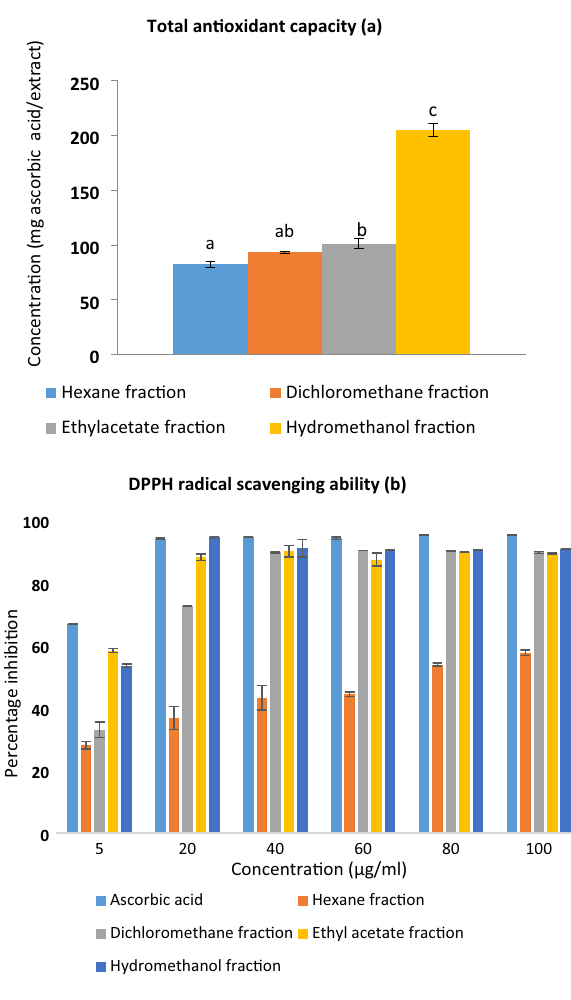
Fig. 2 Antioxidants capacity and free radical inhibiting activity of A. floribunda stem bark fractions a Total antioxidant capacity of A. floribunda stem bark fractions; b DPPH radical scavenging ability of A. floribunda stem bark fractions . Data are expressed as mean ± SEM of results from three independent experiments. Bars with different lowercase letters represent significant difference between mean at p ˂ 0.05